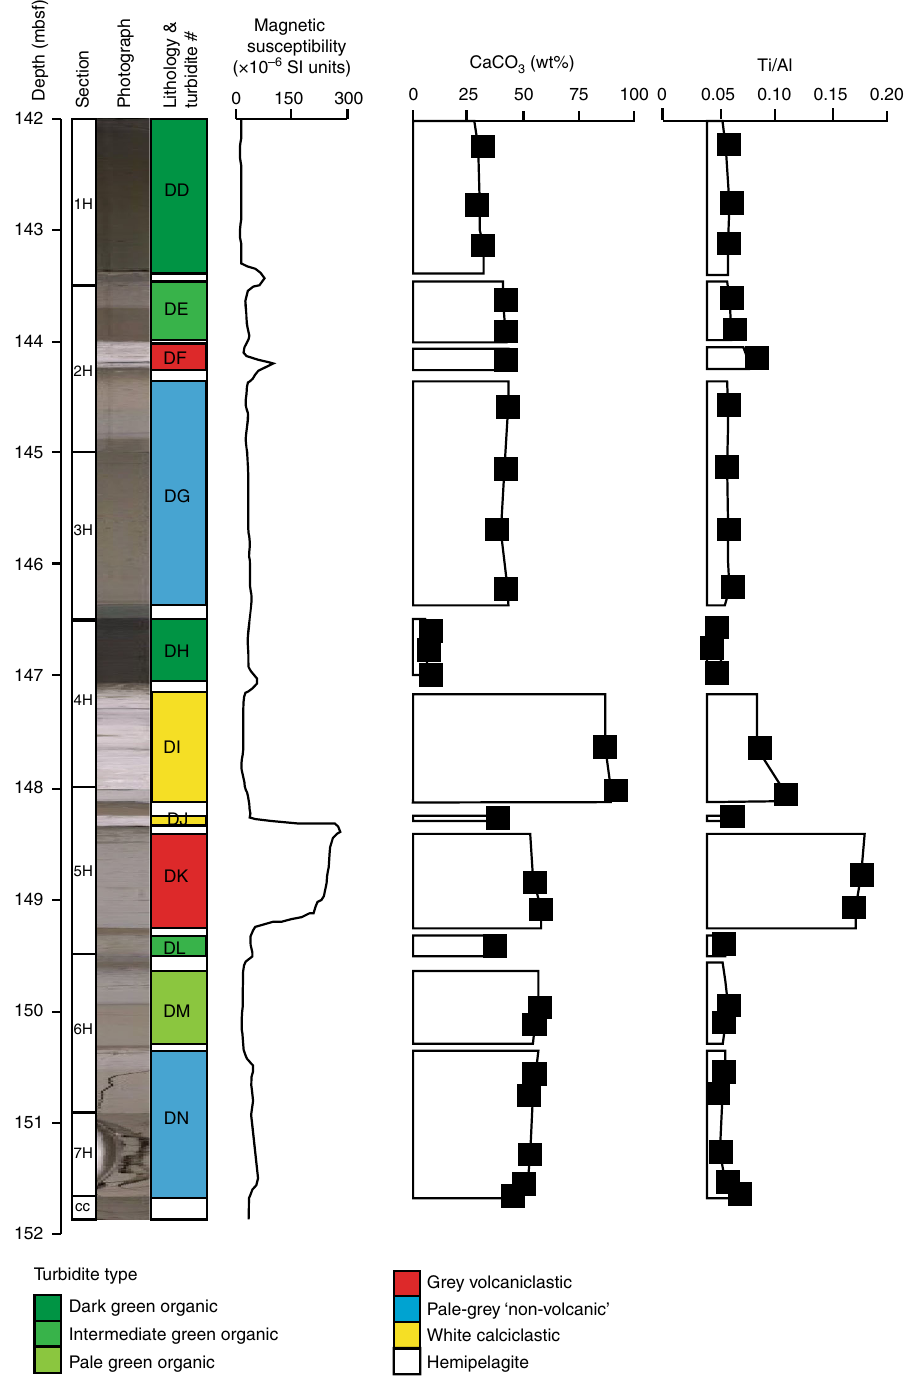
Fig. 2 Example ODP core from Site 950 featuring sections from Core 16 H of Hole 950 at 142 – 152 mbsf. This illustrates all the turbidite types, with the pale- grey ‘ non-volcanic ’ turbidites of interest highlighted in blue (beds DG, DN). Note the pale-grey colour, but lack of magnetic susceptibility response, and low Ti/Al seen in the ‘ non-volcanic ’ turbidites, compared to volcaniclastic turbidite DK (red). Black squares represent location of previous samples taken for geochemical the Madeira Abyssal Plain over the last 43 Myr represent large- island (e.g., source area delineated in Fig. 1) associated with volume failures of sea fl oor immediately adjacent to volcanic inception, ascension and emergence during the seamount-phase islands that instead comprise accumulated hemipelagite sedi- of growth and later subaerial-phase of growth. Volcanic islands ments and distributed volcaniclastic sediments beyond the vol- above intra-plate plumes grow more rapidly during their canic island slopes. We propose that these landslides and the seamount-phase their contemporaries and become subaerial resultant turbidity currents occurred in response to magma volcanic edi fi ces in an order of magnitude less time than is taken ascension and doming of the sea fl oor adjacent to the volcanic to develop mid-ocean ridge seamounts. For example, El Hierro or